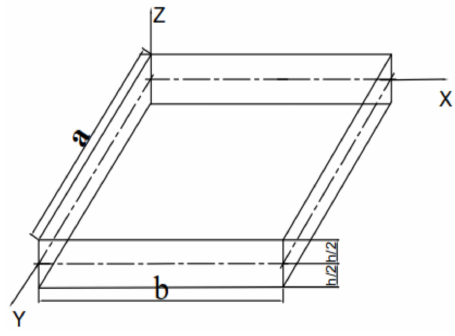
Figure 1. Geometrical configuration of the